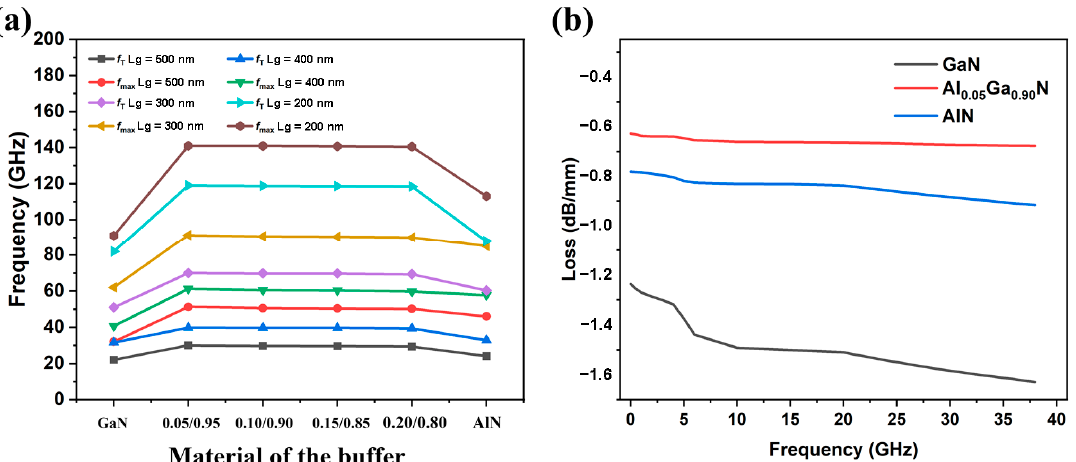
Figure 4. ( a ) The cut-off frequency ( f T ) and the maximum oscillation frequency ( f max ) of the HEMT buffer layer of different materials and gate lengths. ( b ) The RF losses of the CPW structure with the HEMT buffer layer of different materials.